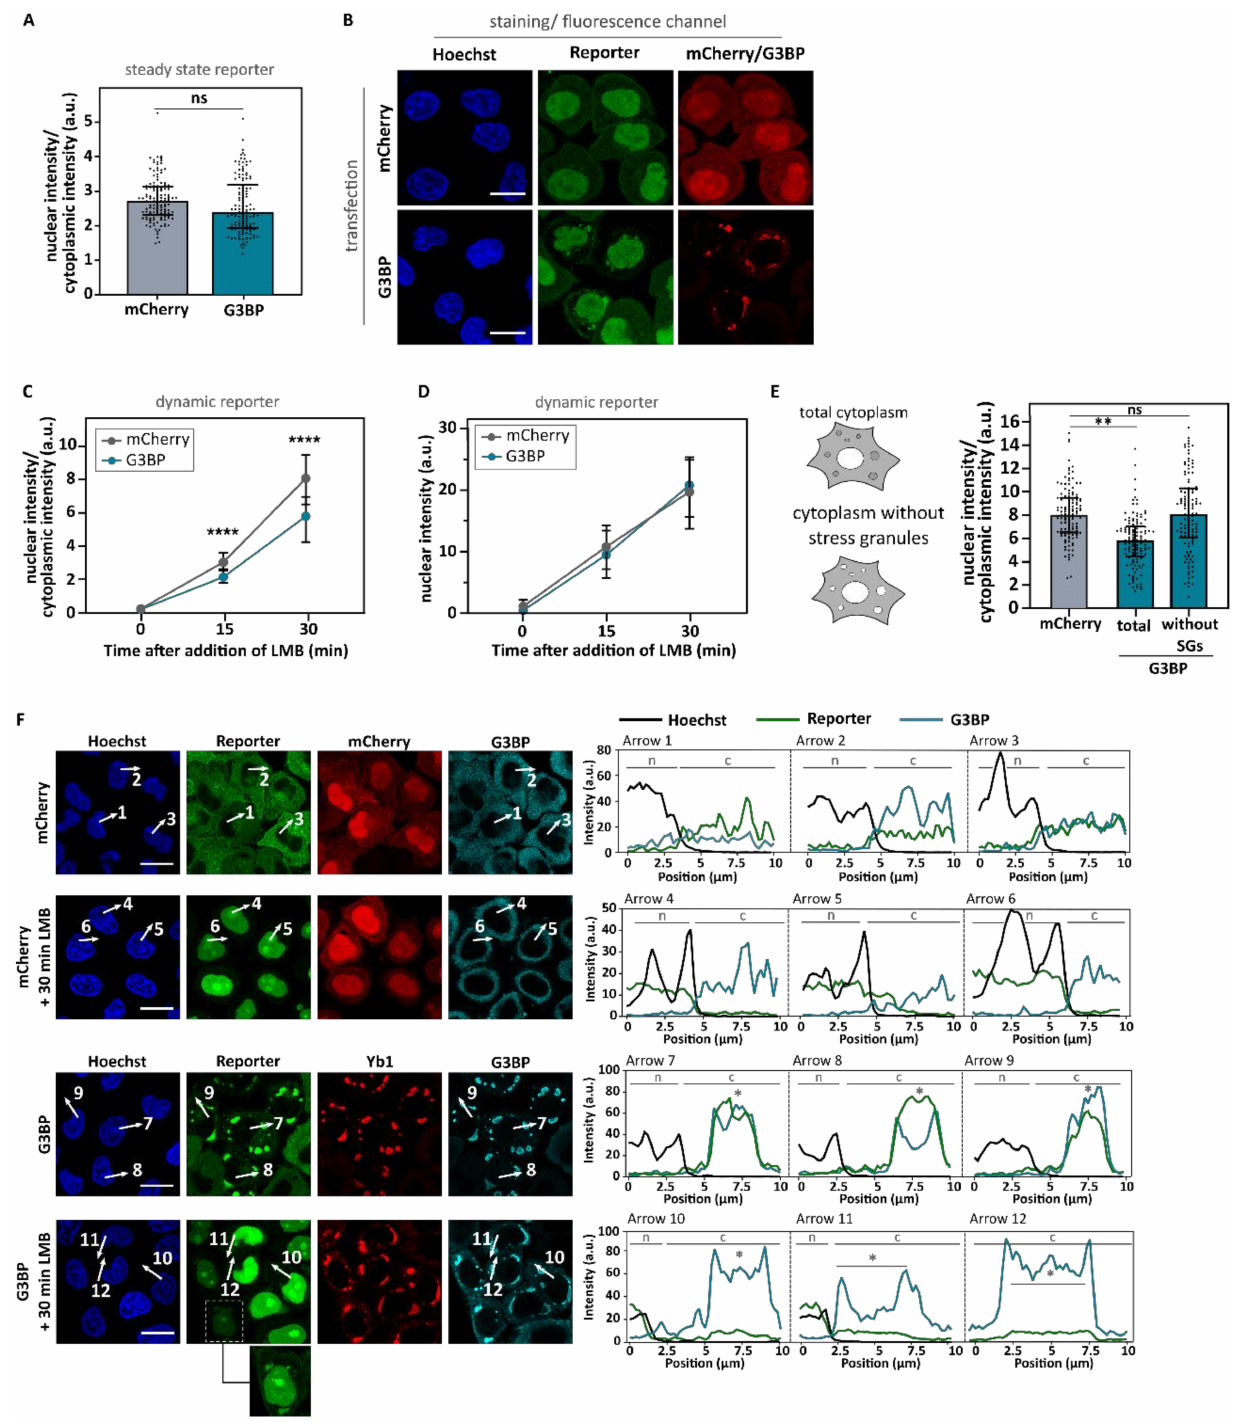
Figure 7. Induction of stress granules via the overexpression of G3BP1 does not impede nuclear import. (A ). HeLa Kyoto cells expressing the NLS c-myc -GFP 2x -NES ikb2 reporter were transfected with mCherry or G3BP1-expressing plasmids. After 48 h, nuclear and cytoplasmic intensity of the reporter was measured in mCherry-expressing cells without stress granules and G3BP-expressing cells with stress granules. No significant decrease in nuclear import was observed. Confocal images were analyzed using ImageJ. Data of three experiments were used. N = 90 of which each data point is one cell (30 cells per experiment). Mann–Whitney U test. Medians ± IQR. Ns: no significant difference. ( B ). Representative images of NLS c-myc -GFP 2x -NES ikb2 cells used in panel ( B ). Despite the strong localization of the reporter at G3BP overexpression-induced stress granules, no decrease in